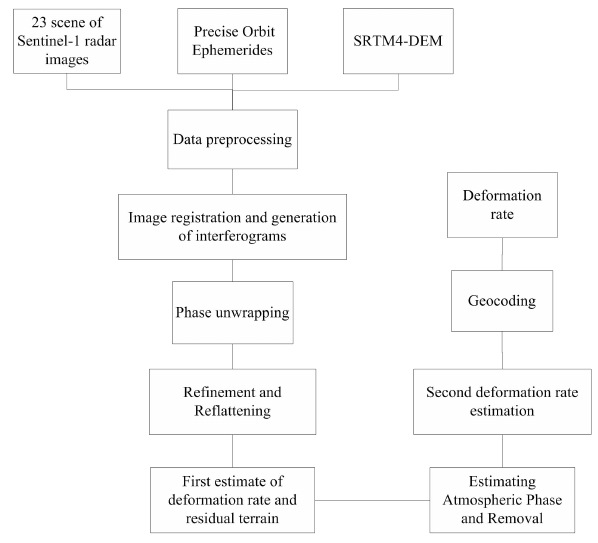
Figure 3. Data Processing Process